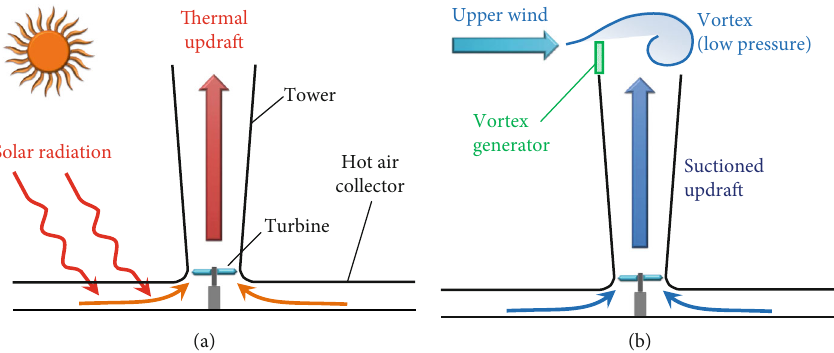
Figure 1: The mechanisms of the wind solar tower: (a) solar energy utilization of the WST; (b) wind energy utilization of the WST.